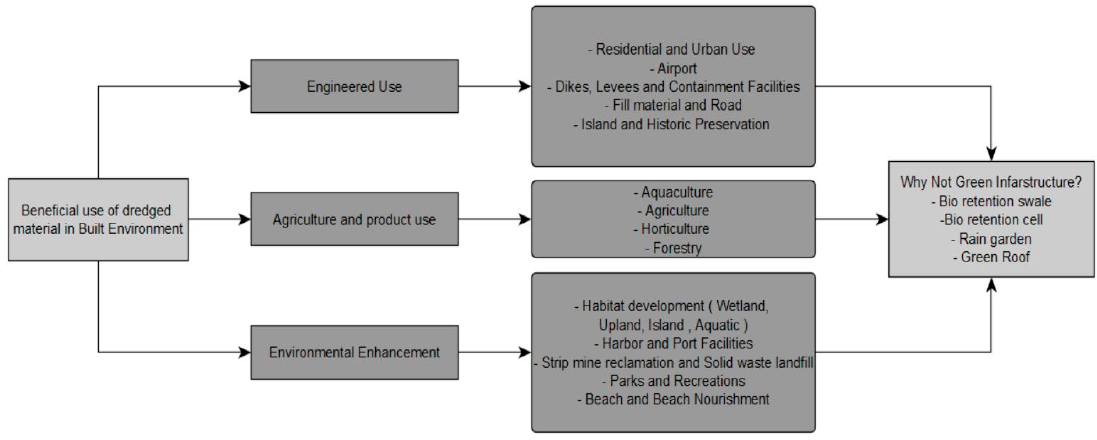
Figure 2. Benefits of dredged material (Ref: [1,6]).